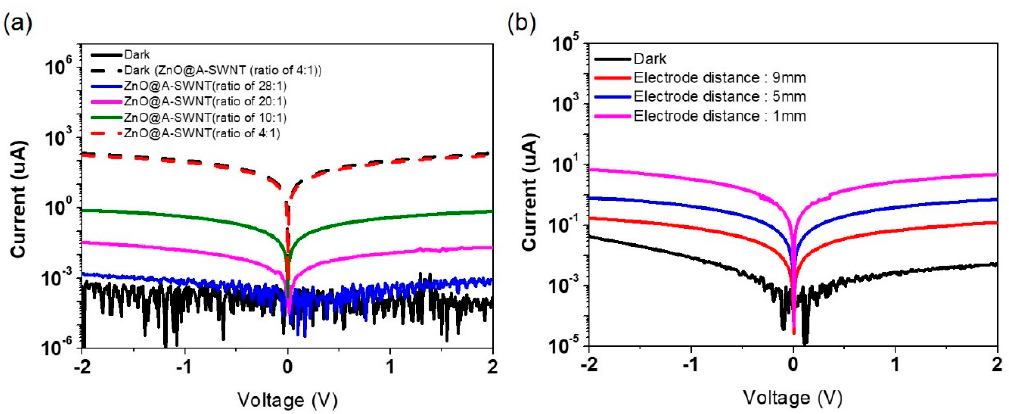
Figure 9. I–V characteristics of ( a ) ZnO@A-SWNT PDs with varying concentrations of A-SWNTs: 28:1, 20:1, 10:1, and 4:1 (ZnO:A-SWNT, w : w ). ( b ) I–V characteristics of ZnO@A-SNWT PDs at di ff erent electrode distances: 1 nm, 5 nm, and 9 nm. The wavelength of the UV light was 254 nm (0.47 mW / cm 2 ).